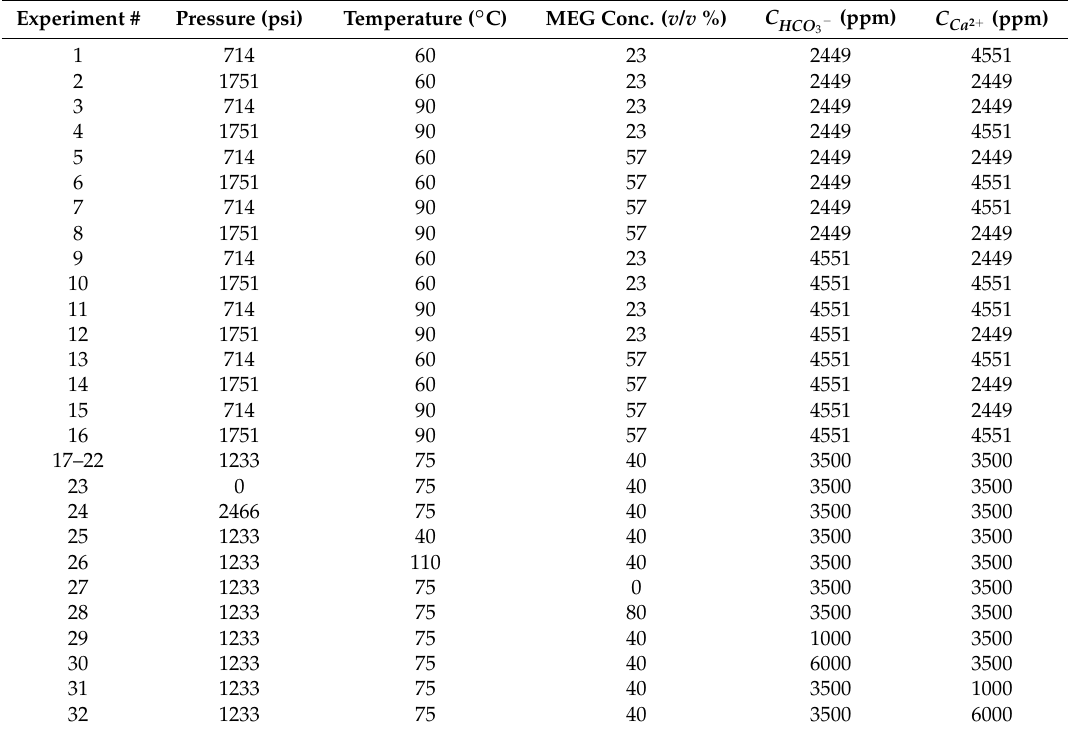
Table 1. Experimental table of the central composite